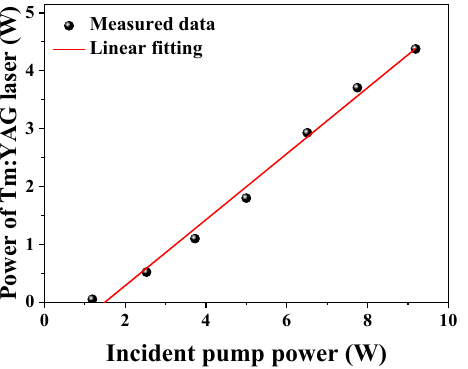
Figure 3. The output optical power of Tm:YAG laser varies with the incident pump. The absorption spectrum of the crystal was an important reference for selecting the laser pump wavelength and determining the laser polarization mode. Figure 4 shows the output optical spectrum of the Tm:YAG laser and the absorption of the Ho:GdVO 4 crystal together. The central wavelength of the Tm:YAG laser at the maximum output power was 2014.1 nm with a full width at half maximum (FWHM) of 1.9 nm, measured with a spectrometer of Bristol 721A (Bristol Instruments, Inc., Victor, NY, USA). It can be seen from Figure 4 that the Ho:GdVO 4 crystal had strong peak absorption in both σ and π polarization directions around 2014 nm, which provided a feasible principle support for the construction of the intra-cavity Ho:GdVO 4 laser.